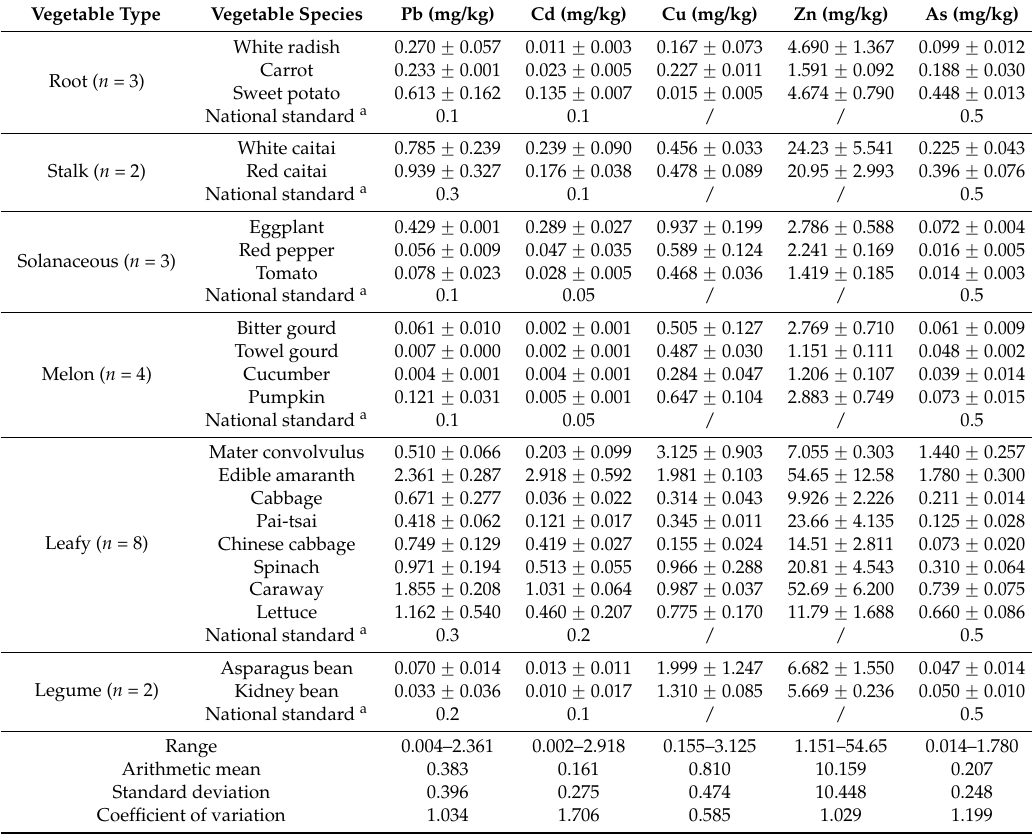
Table 3. Concentrations of heavy metals in vegetable edible parts (mg/kg, f.w.). Data show mean ˘ standard error of three